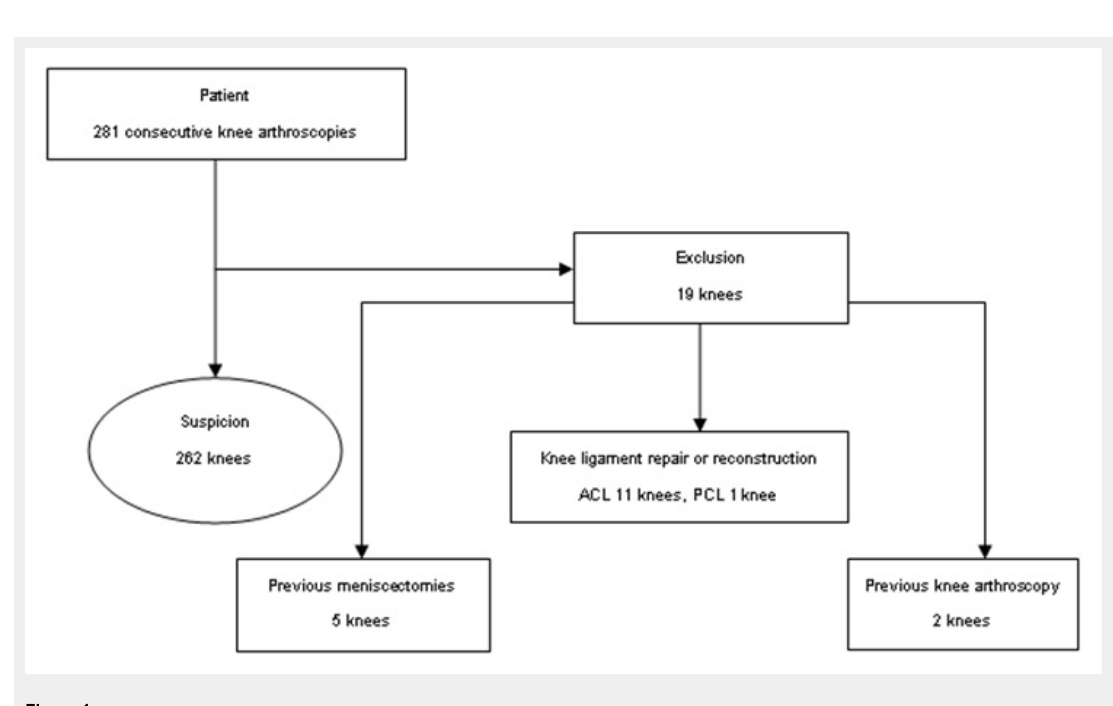
Figure 1 Diagram of patients enrolled in the